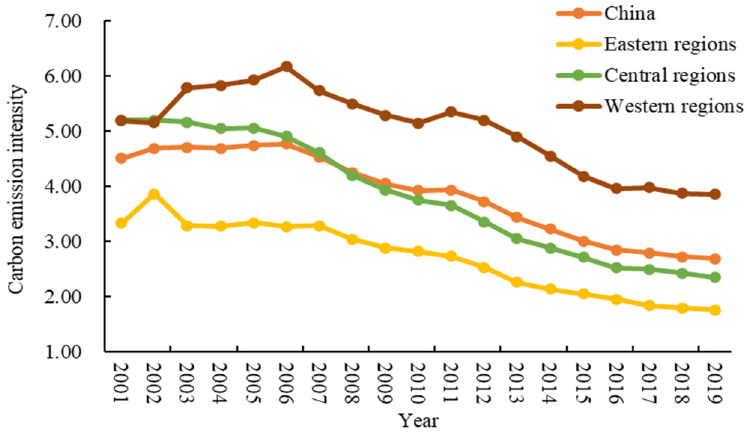
Figure 2. Variation trend of carbon emission intensity in China and the three major regions (2001-